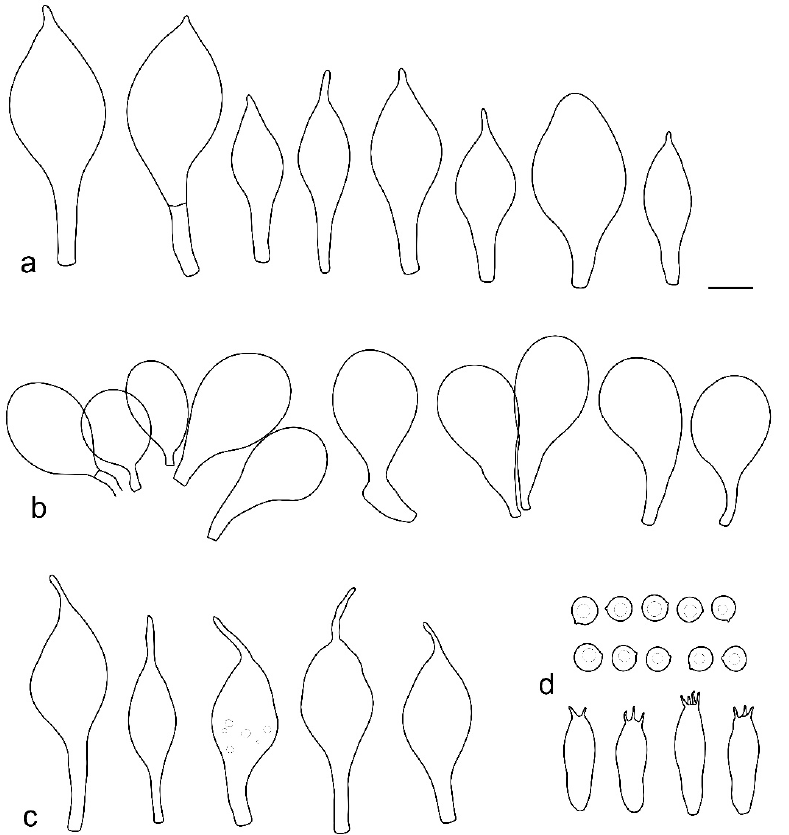
Figure 9. Pluteus flavostipitatus holotype LE 313350: ( a ) cheilocystidia; ( b ) pileipellis elements; ( c ) pleurocystidia; ( d ) basidia and spores. Scale bar 10 µm.